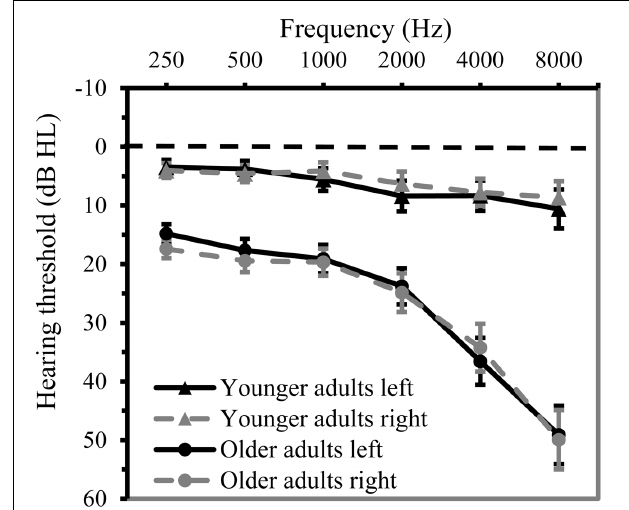
FIGURE 1 | Mean hearing threshold (in dB HL) at 0.25, 0.5, 1, 2, 4, and 8kHz for both ears in younger ( n = 59) and older adults ( n = 73). Error bars indicate two standard error from the